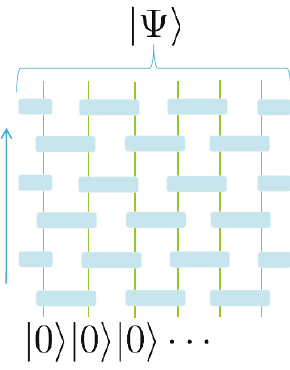
Figure 2 . A quantum circuit representation for a quantum state in a qubit system. A quantum state j (cid:9) i can be constructed by simple local (2-qubit) unitary operations from a simple reference state, for example, a product state j 0 ij 0 ij 0 i (cid:1) (cid:1) (cid:1)